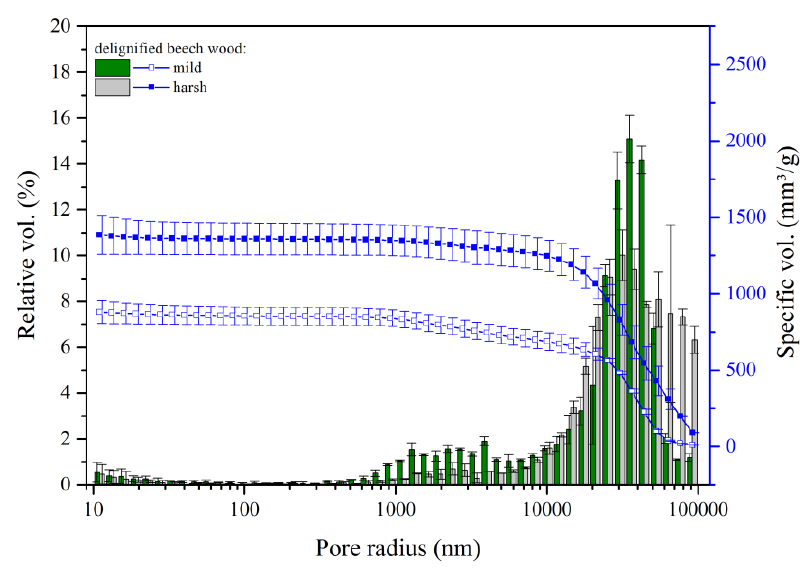
Figure 4. Effect of the extent of delignification on porosity of beech wood. Cumulative pore volume and histogram of relative pore volume as a function of the pore radius of delignified beech wood following the mild (60 °C, 8 h) and the harsh (80 °C, 4 h) delignification method (in both cases, samples were oven dried after delignification).